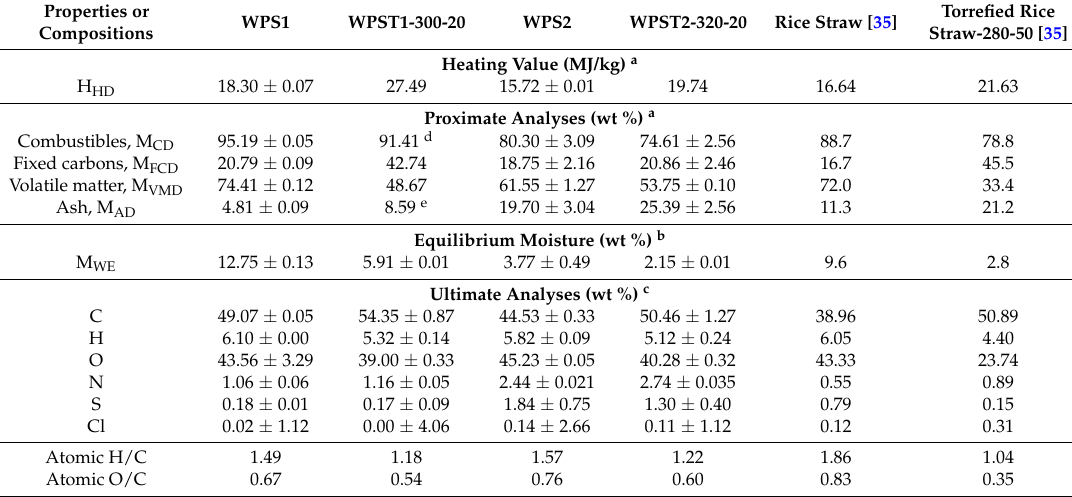
Table 1. Characteristics of WPS and torrefied